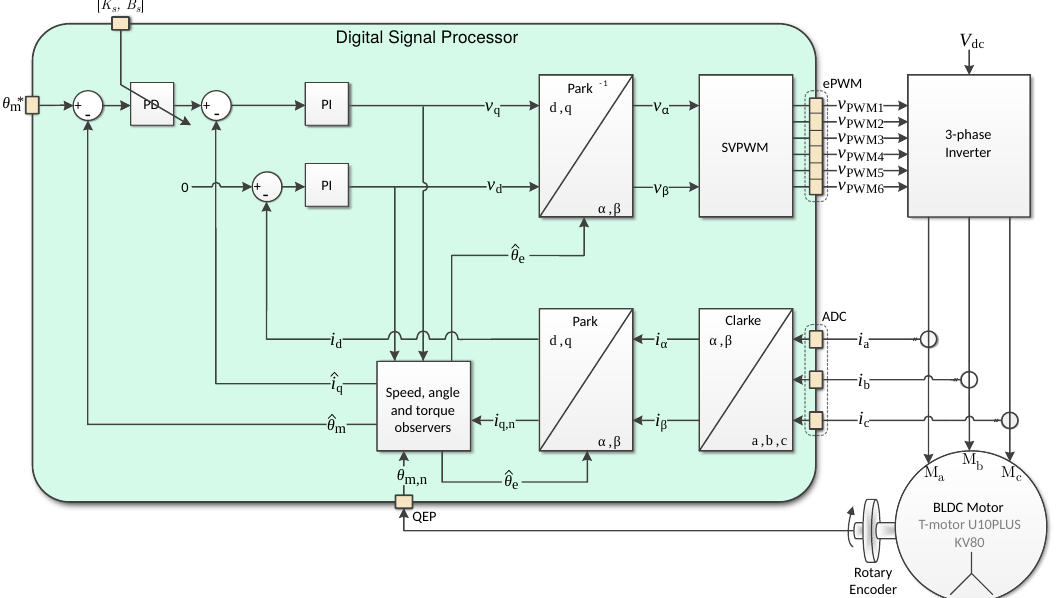
Figure 2. Simplified block diagram of the entire closed loop motor controller system, including Field Oriented Control, angle and current observers, virtual compliance and torque and field controller